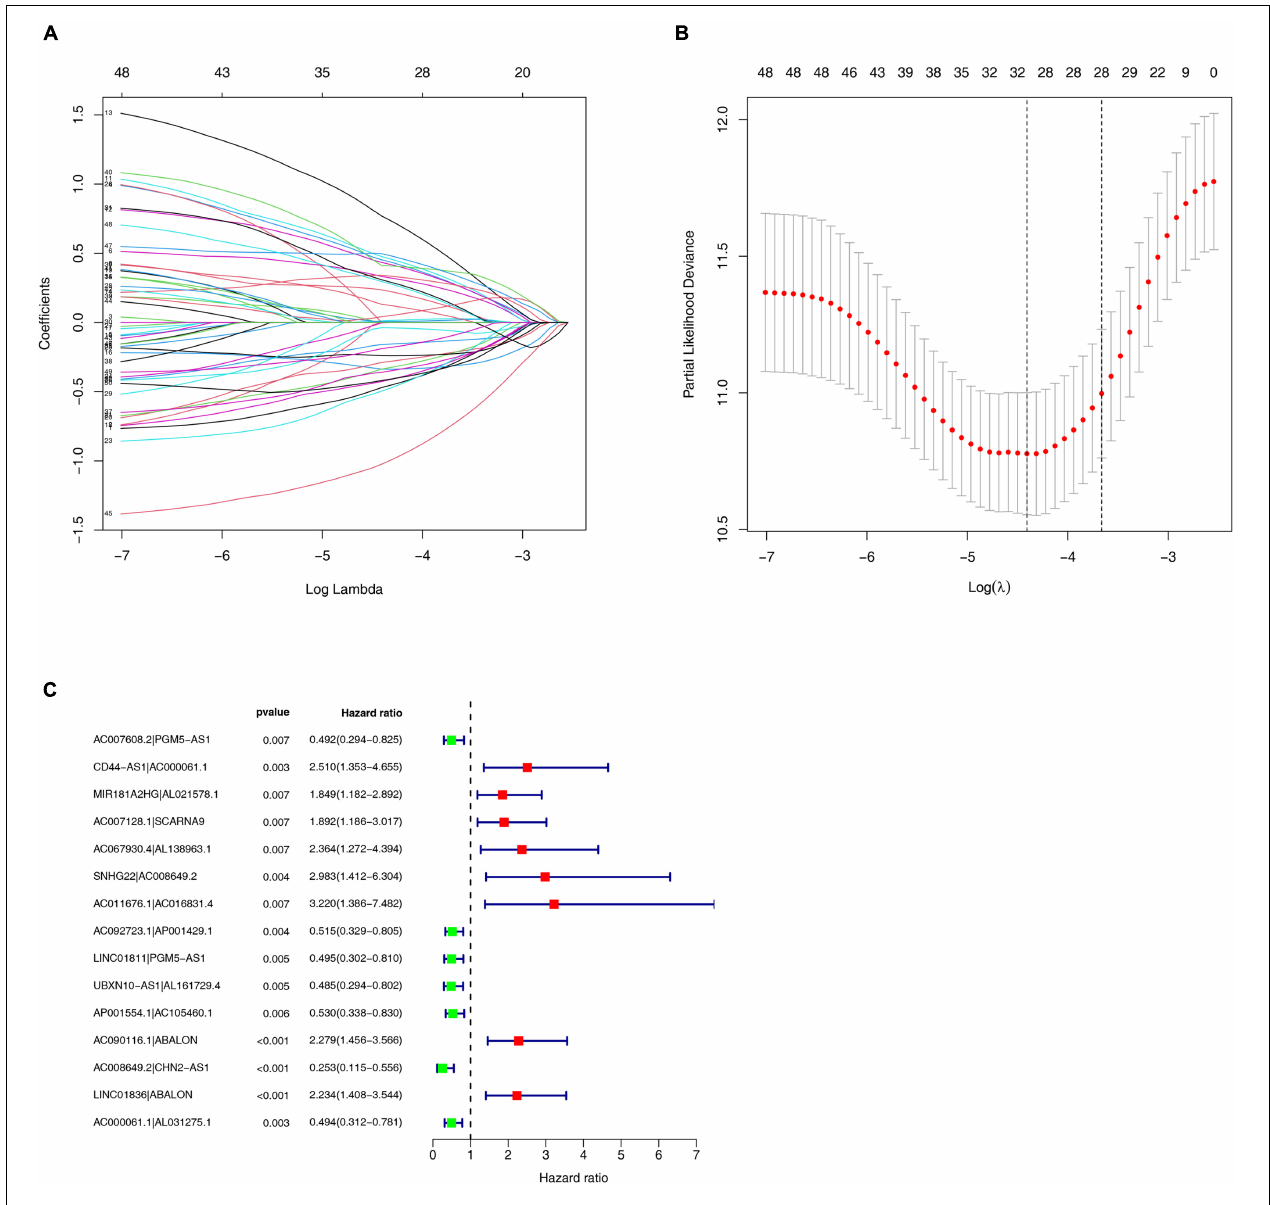
FIGURE 3 | Construction of the risk model using DEirlncRNA Pairs. (A,B) The Lasso Cox analysis of the 30 immune-related lncRNA pairs. (C) A forest plot of 15 DEirlncRNA pairs selected via Cox proportional hazard regression for the construction of the risk model.